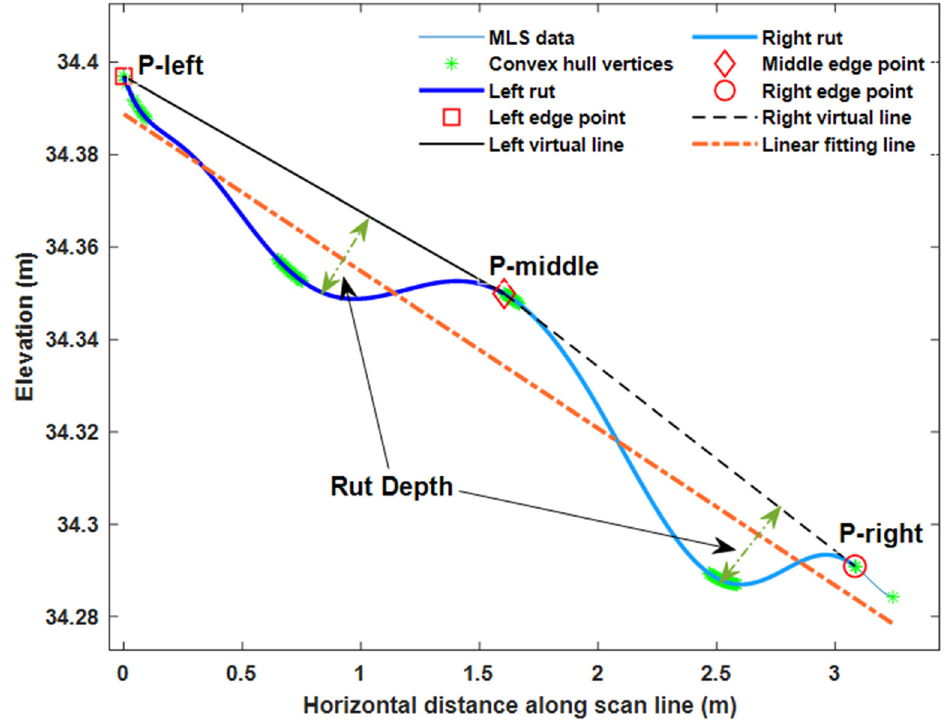
Figure 13. Left and right rut depth calculation for one scan profile in MLS data.